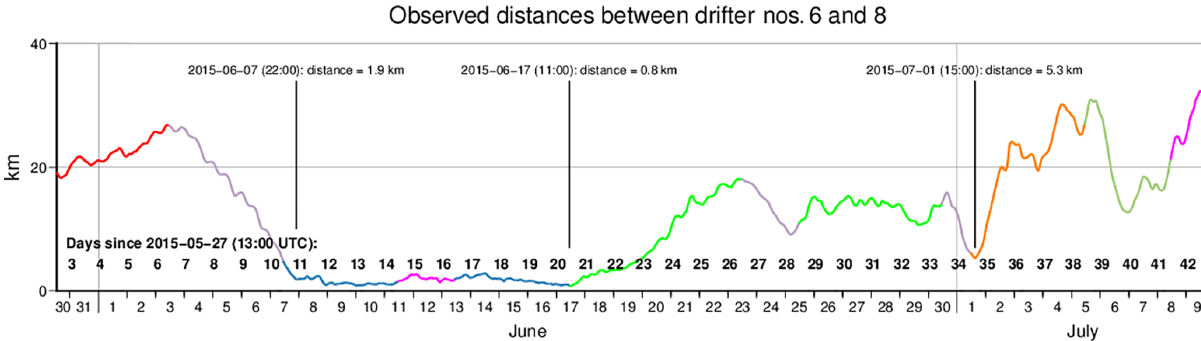
Figure 5. Observed distances between drifter nos. 6 and 8. Colours refer to those specified in Table S1.